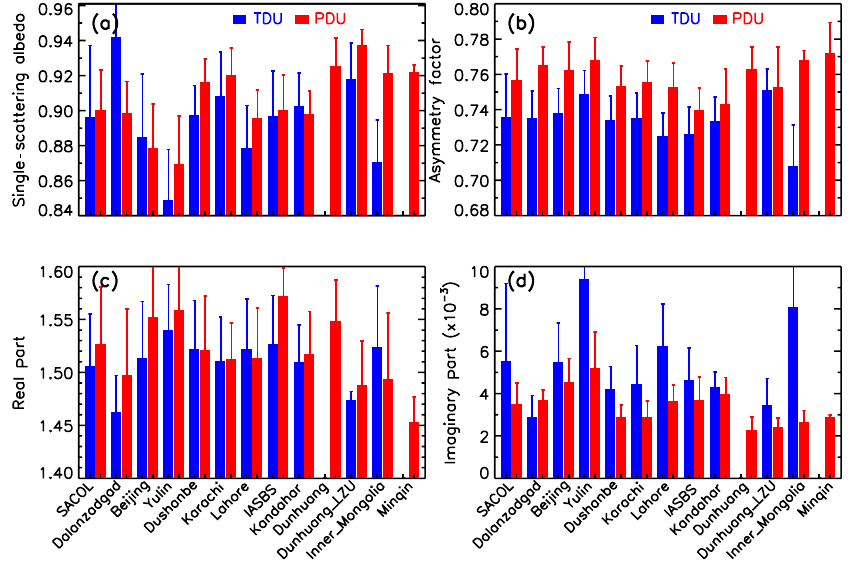
Figure 7. The same as Fig. 5, but for (a) single-scattering albedo, (b) asymmetry factor, and (c) real part and (d) imaginary part of complex refractive index at